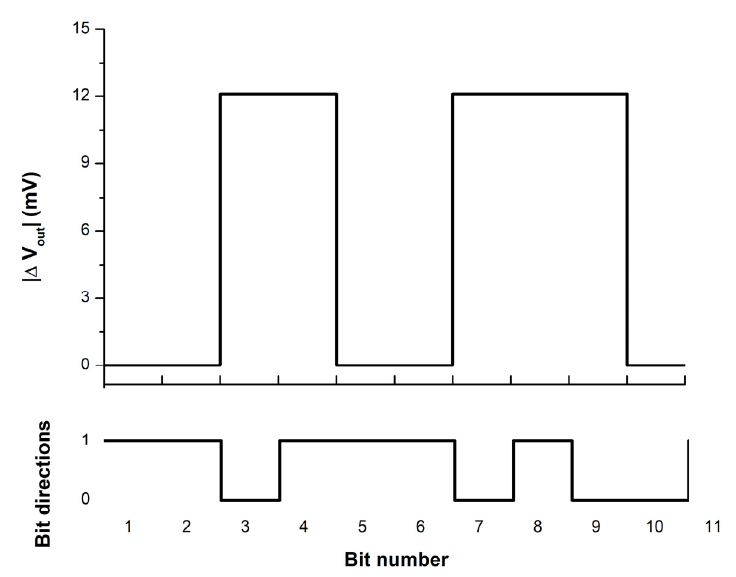
Figure 14. The different readback voltage for different magnetic bit directions.